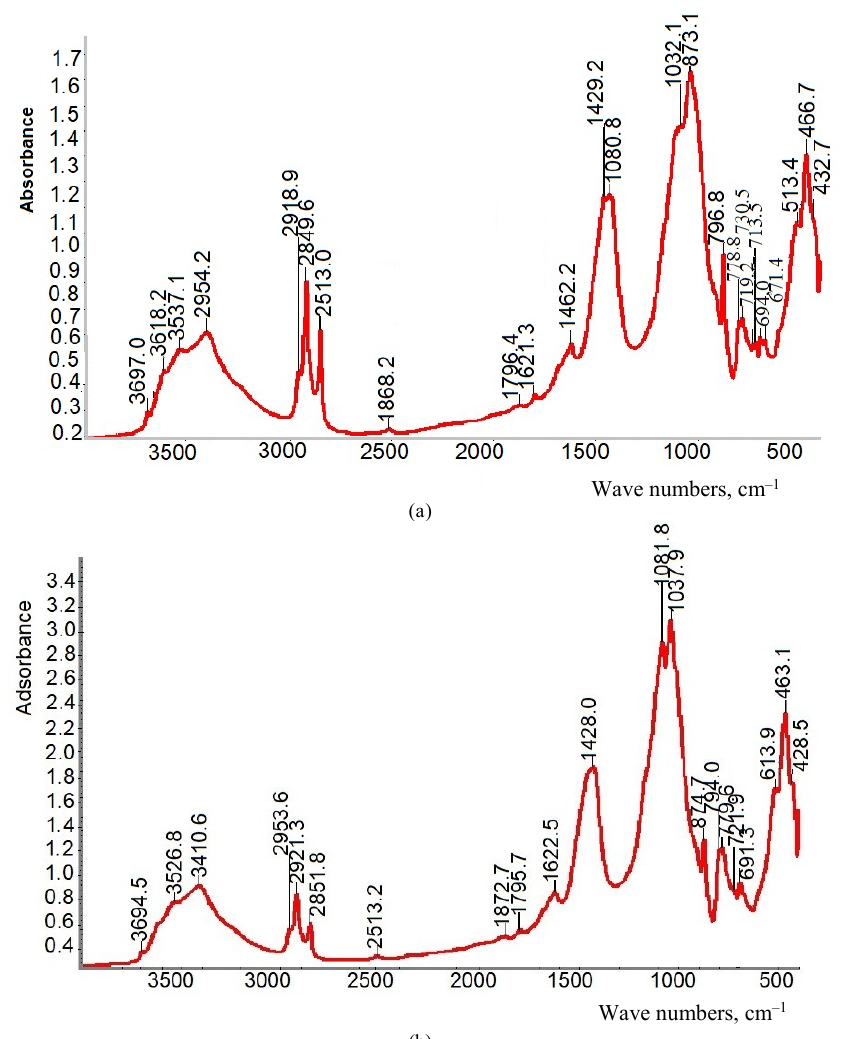
Fig. 3. The IR spectra of soil - concrete produced on the basis of oil - contaminated soil with an additive : a) experimental, b )